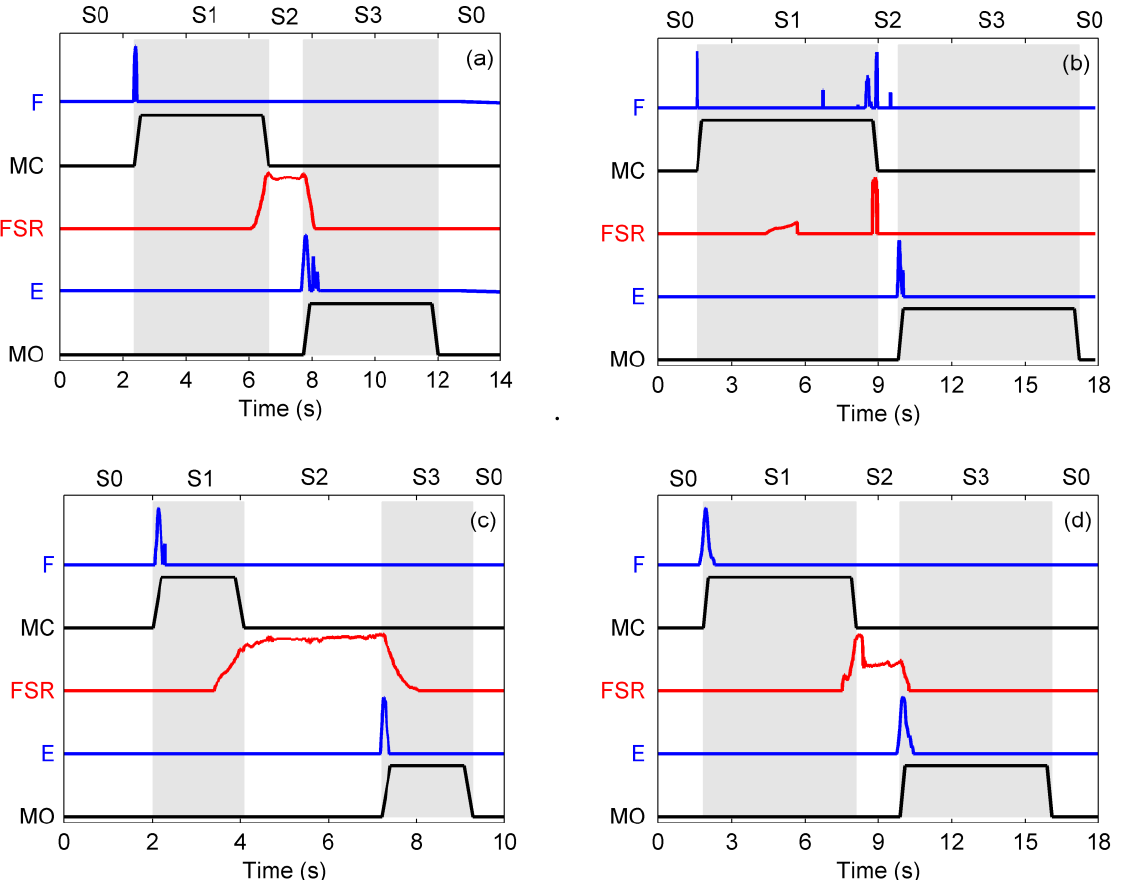
Figure 8. Grasping objects with the glove-like orthosis: ( a ) glue stick, ( b ) adhesive tape roll, ( c ) bottle, and ( d ) toy. F: FMG flexion stimulus; MC: motor command to close the hand; FSR: grip contact force; E: FMG extension stimulus; MO: motor command to open the hand. The measured signals are normalized and scaled for the sake of visualization. The gray rectangles indicate the system states.